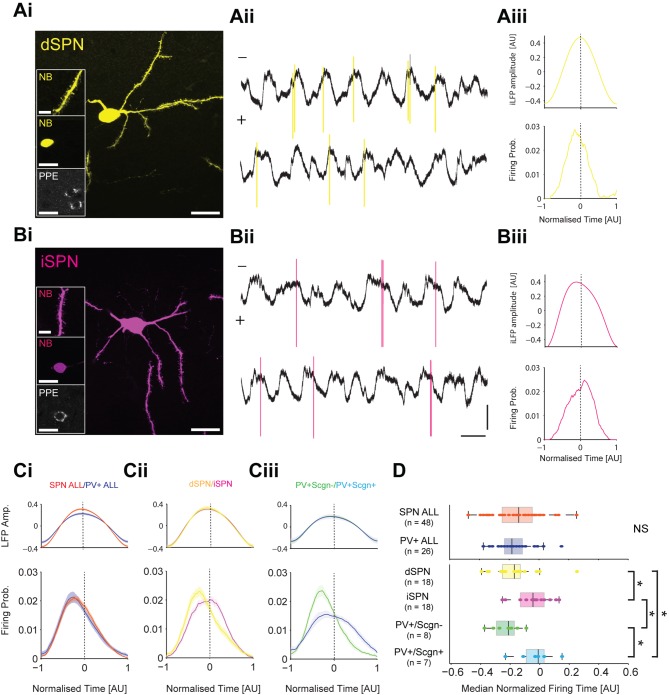
PV+/Scgn- and PV+/Scgn+ interneurons differ in their temporal relationships with spiny projection neurons of the direct and indirect pathways.(Ai) Striatal projection neuron (SPN), juxtacellularly labelled with neurobiotin (NB) and identified by its densely spiny dendrites (top inset). This neuron’s soma does not express immunoreactvity for PPE (middle and bottom insets), identifying it as a direct pathway SPN (dSPN). (Aii) Two 10 s epochs of the inverted local field potential (iLFP) that were simultaneously recorded with single-unit activity in the striatum (all from same glass electrode). The identified dSPN tended to fire action potentials (yellow) just before and around the peaks of the iLFP. (Aiii) Histograms of iLFP amplitude (top) and dSPN spike firing (below), confirming that the dSPN fires most often before the center of the iLFP peak. (Bi) Juxtacellularly-labelled indirect pathway SPN (iSPN), identified by its somatic expression of PPE. (Bii, Biii) The iSPN tended to fire action potentials (magenta) just after and around the peaks of the iLFP (Bii), which is confirmed by the histograms of iLFP amplitude and spike firing (Biii). (C) Mean iLFP histograms and spike-firing probability histograms for all SPNs and all PV+ interneurons recorded (i), for identified dSPNs and iSPNs (ii), and for identified PV+/Scgn- and PV+/Scgn+ interneurons (iii). Note that, when considered as whole populations, SPNs and PV+ interneurons fire at similar times with respect to the iLFP, but also that firing times diverge when the SPN and PV+ interneuron populations are divided according to their dichotomous molecular identities. (D) The median firing times of all SPN and all PV+ interneurons are not significantly different (upper plot). When the subpopulations are analyzed (lower plots), dSPNs fire significantly earlier than iSPNs, and PV+/Scgn- interneurons fire significantly earlier that PV+/Scgn+ interneurons. Furthermore, PV+/Scgn- interneurons fire significantly earlier than iSPNs, but not dSPNs. Note also that PV+/Scgn+ interneurons fire significantly later than dSPNs (Kruskal Wallis ANOVA on rank [p=0.0006] with post-hoc Dunn tests). AU, arbitrary units. (Ai, Bi, Scale bars are 20 µM, except for those in dendrite images, which are 5 µM Aii, Bii, Vertical scale bars for unit activity and iLFPs are 1 mV; Horizontal scale bars are 1 s).DOI:
http://dx.doi.org/10.7554/eLife.16088.01710.7554/eLife.16088.018Figure 9—source data 1.Source data for Figure 9C, D.